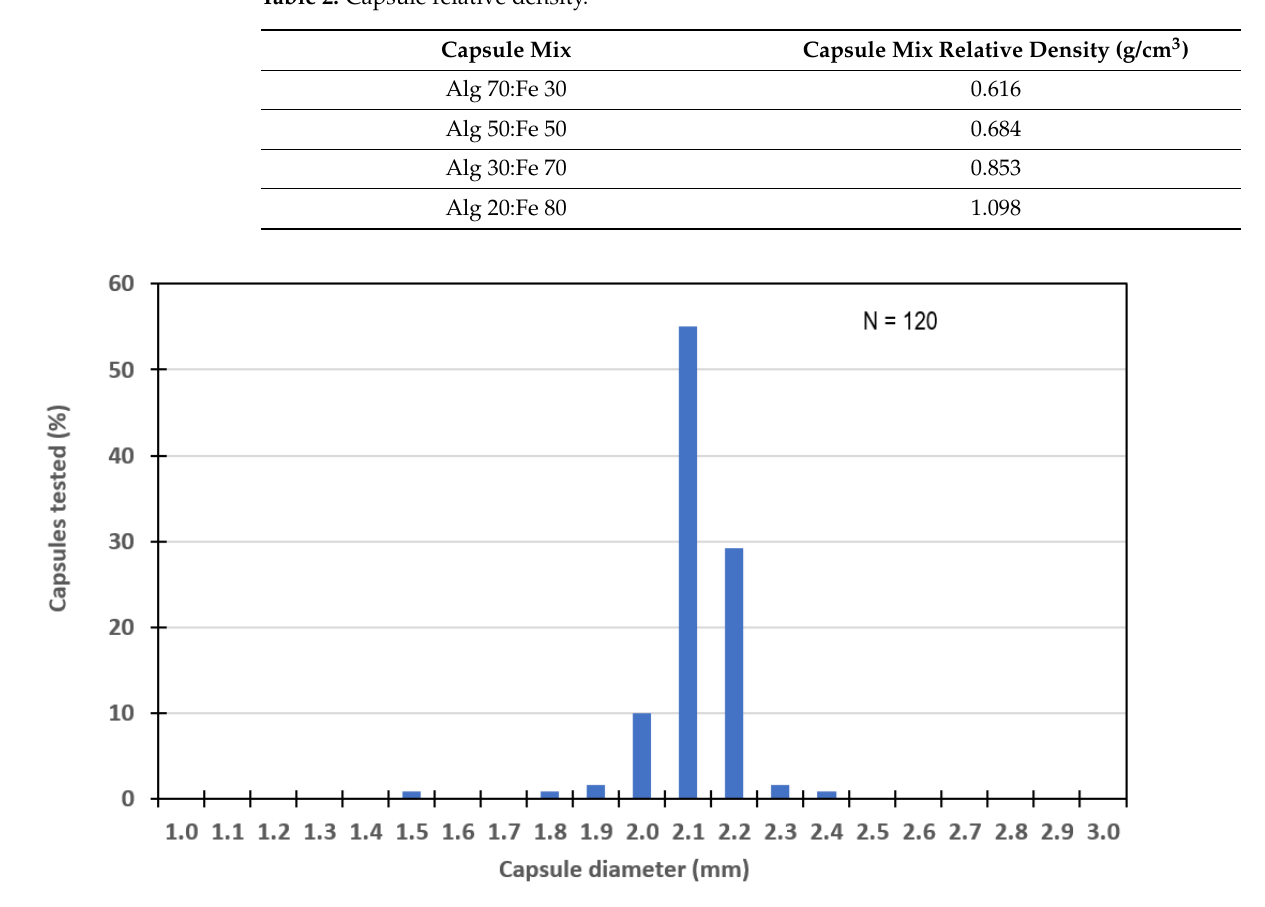
Table 2. Capsule relative density.